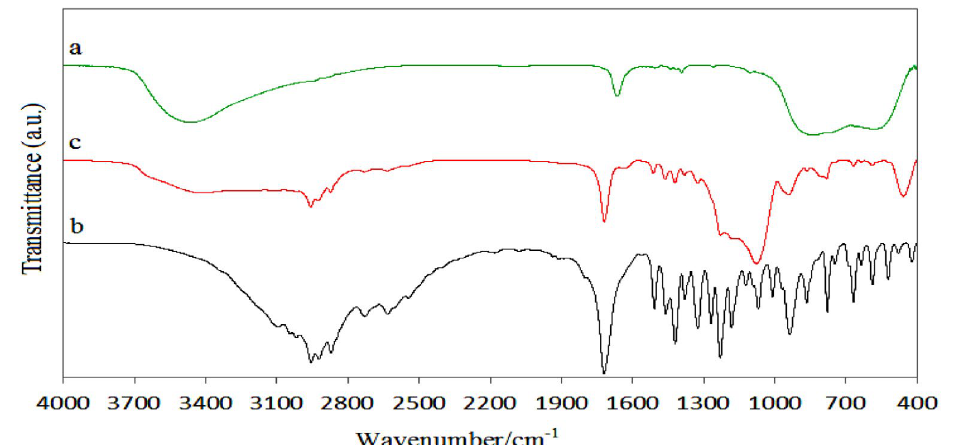
Fig. 2. FT-IR spectra of (a) γ-alumina (γ-Al), (b) ibuprofen (IBU) and (c) 25% ibuprofen supported γ-alumina